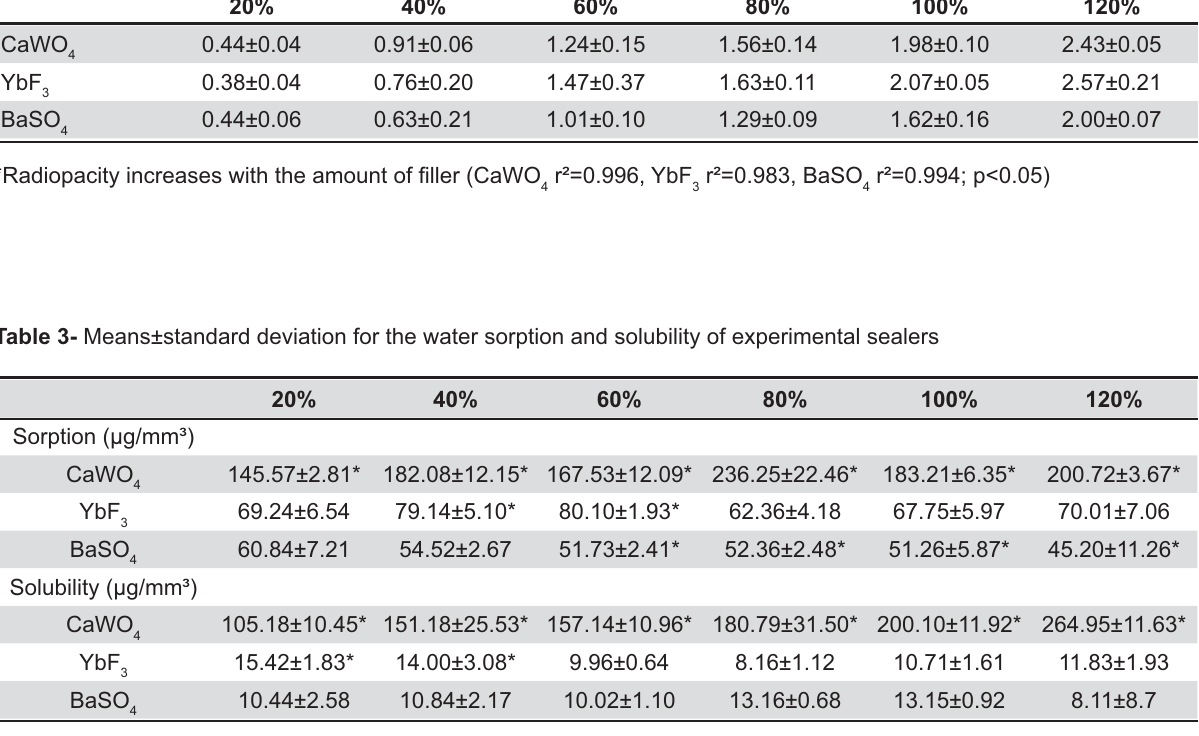
*Statistical difference (p<0.05) against control group. Water soprtion and solubility of control group are 64.28±3.79 μg/mm³ and 9.93±2.20 μg/mm³, respectively